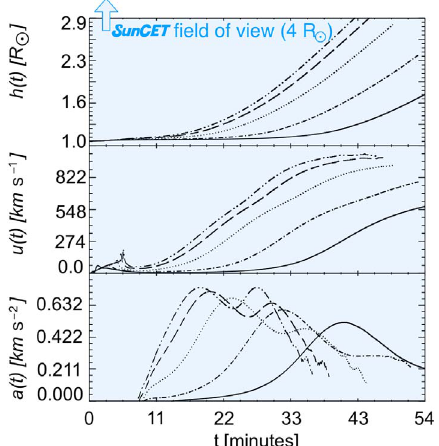
Fig. 3. Simulated CME kinematic pro fi les. Solid lines indicate the unperturbed torus instability. Dashed lines from right to left correspond to increasing durations (6 s A up to 10 s A ) of an upward, linearly rising velocity perturbation, resulting in fundamentally different acceleration pro fi les. The SunCET FOV (0 – 4 R (cid:1) ; indicated in light blue) covers and extends beyond this simulation. Adapted from Schrijver et al. (2008), Figure